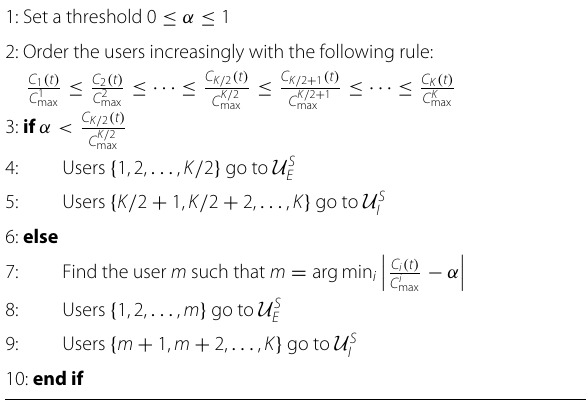
Table 3 Algorithm to obtain the superframe sets U S